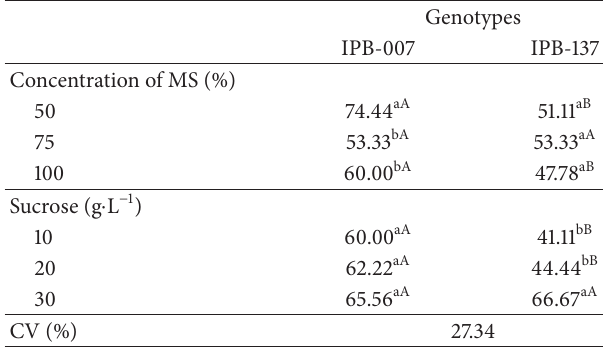
The means followed by the same uppercase letters in the same line and lowercase letters in the same column do not significantly differ according to a Tukey test at a 5%